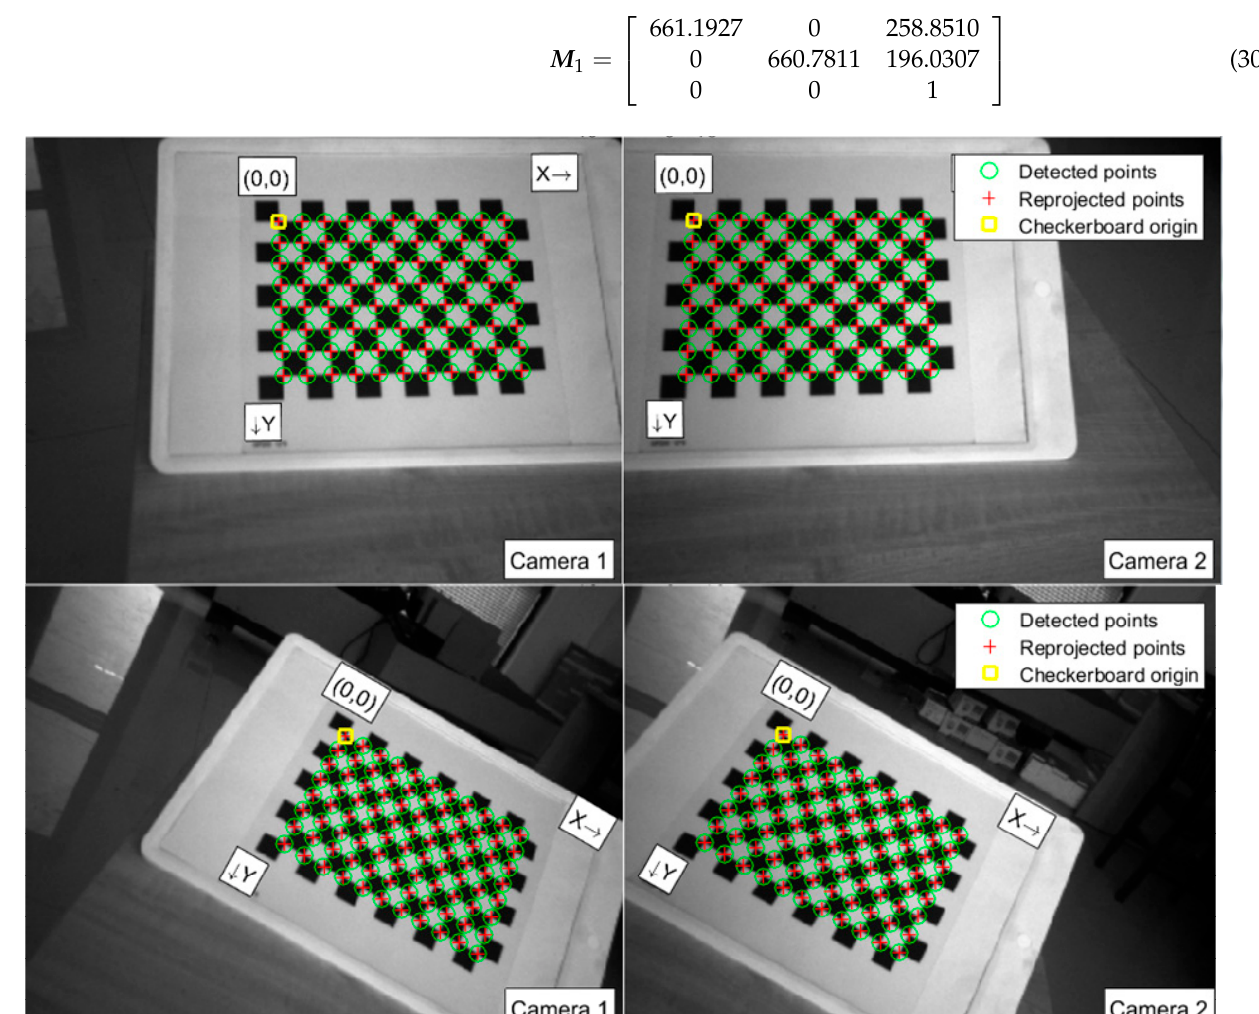
Figure 8. Partial calibration figures.